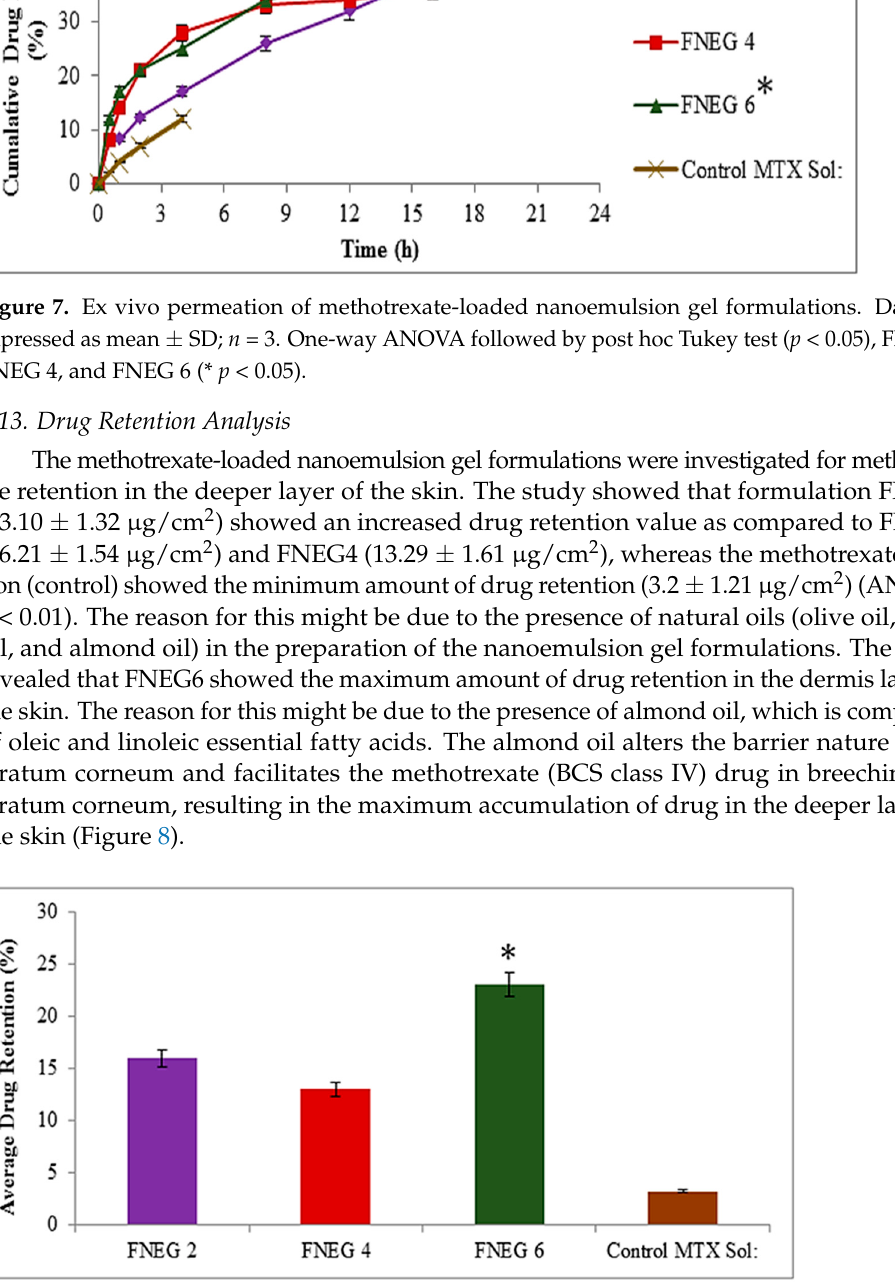
Figure 8. Amount of drug retained ( µ g/cm 2 ) in dermal layer of skin (* p < 0.01 vs. FNEG 2, FNEG 4, and FNEG 6).